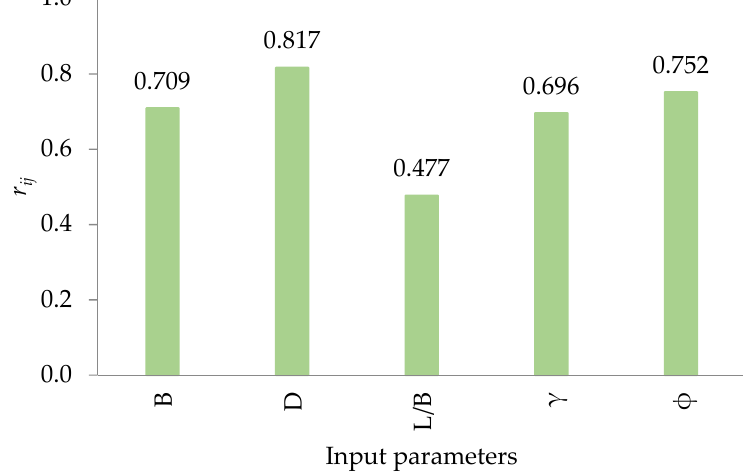
Figure 4. Sensitivity analysis of input parameters.